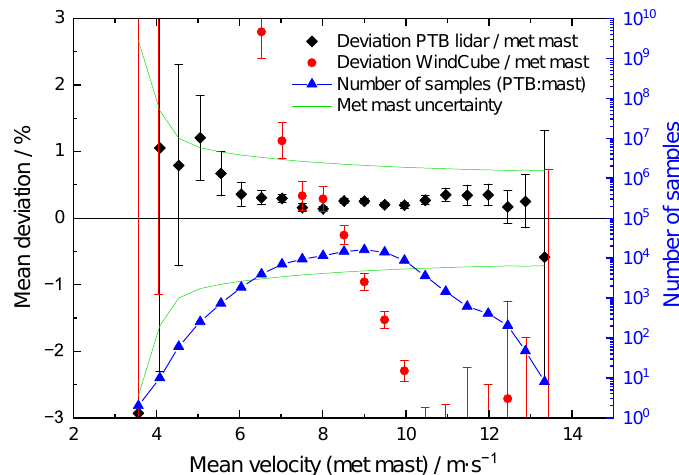
Figure 9. Results of the 2016 comparative measurement between the PTB bistatic lidar and the top anemometer and between the monostatic lidar (WindCube) and the top anemometer in undisturbed flow at a measurement height of 135 m, evaluated according to IEC 61400-12-1 using 1 s intervals. The monostatic lidar shows large deviations, while the PTB bistatic lidar’s deviation only increases significantly beyond 1% at very low or very high wind speeds.